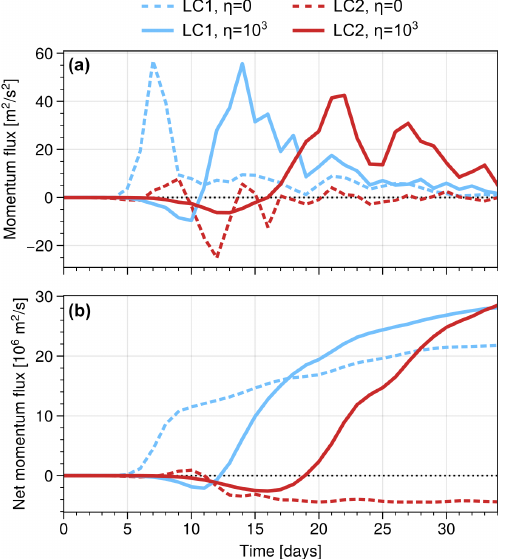
Figure 9. Evolution of (a) hemispherically averaged eddy momen- tum flux and (b) accumulated net eddy momentum flux for ex- periments with either LC1 or LC2 initial conditions and either no ( η = 0) or strong ( η = 10 3 ) initial noise perturbation. Experiments with noise show the average over three different